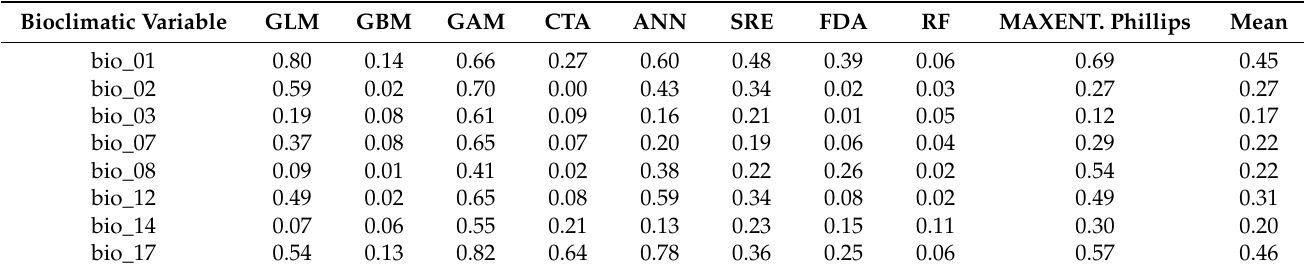
Table 4. Algorithm-wise importance scores of the different bioclimatic variables that were retained for modeling of Valeriana wallichii